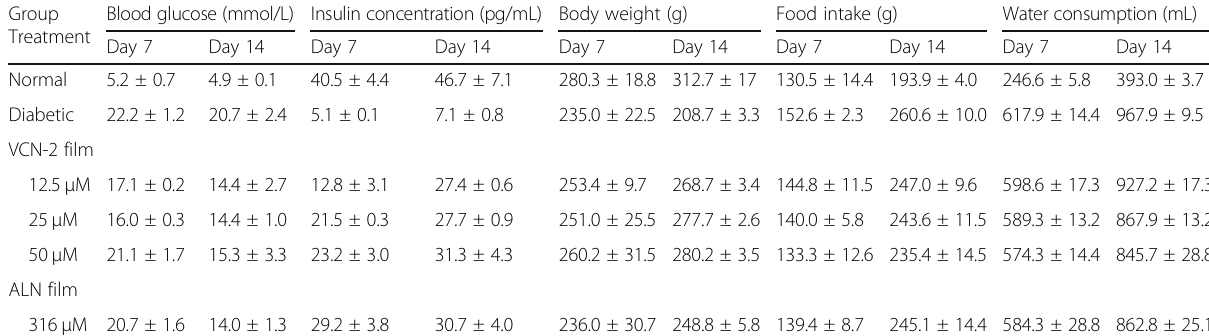
Table 3 Total blood glucose, insulin level, body weight, food intake and water consumption of treatment groups of rats on day 7 and 14 Group Blood glucose (mmol/L) Insulin concentration (pg/mL) Body weight Treatment